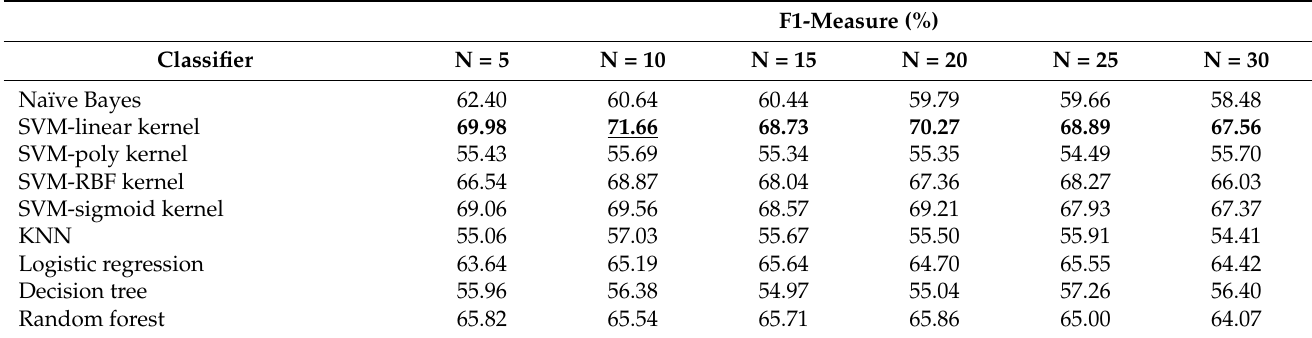
Table 9. Impact of chosen N value for the N-fold